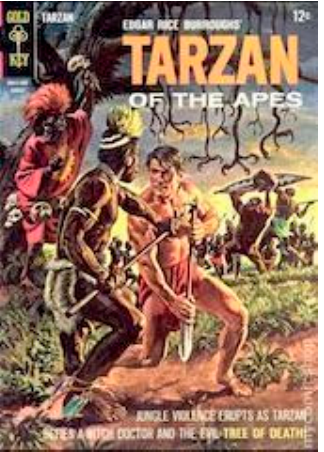
Figure 5. Voodoo Doctor from Tarzan comic book, 1965.